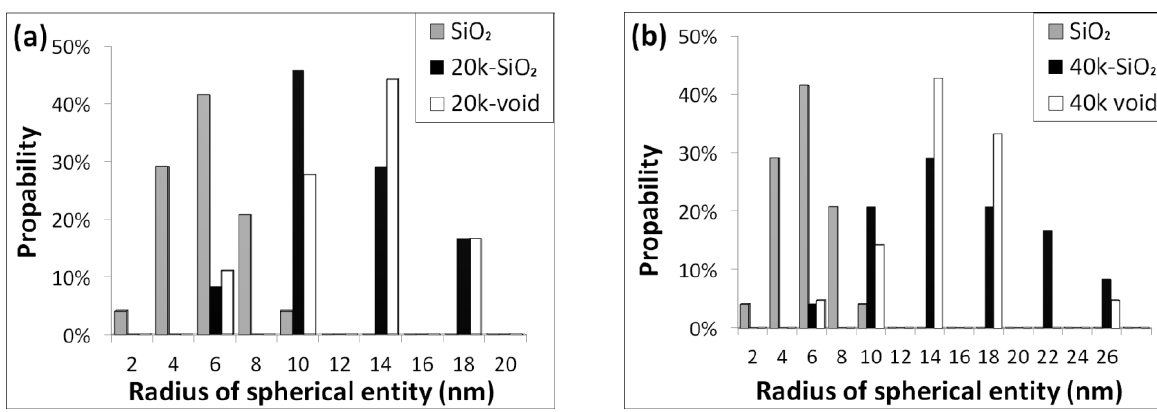
core size, 20 kg/mol PHMA-SiO 2 core size, 40 kg/mol PHMA-SiO 2 in 40k40k systems. 2